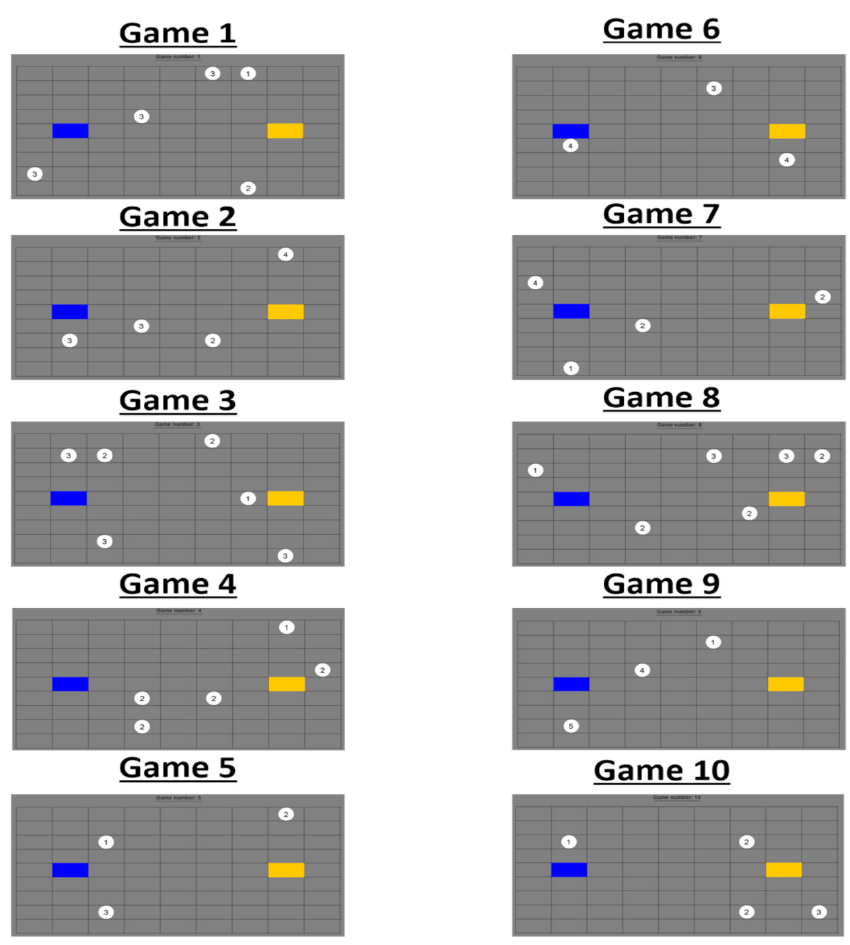
Figure A1. The set of ten predefined games.